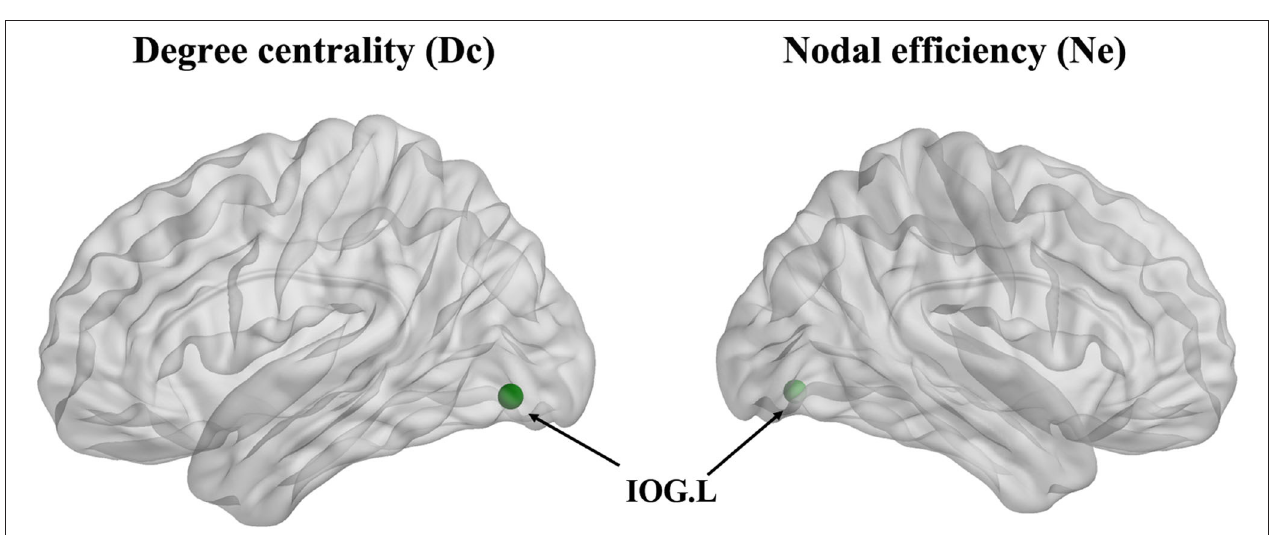
FIGURE 3 | The degree centrality (Dc) and nodal efficiency (Ne) of the left inferior occipital gyrus (IOG.L) in the ARHL patient group showed a decrease compared with the healthy controls group ( p < 0.001).